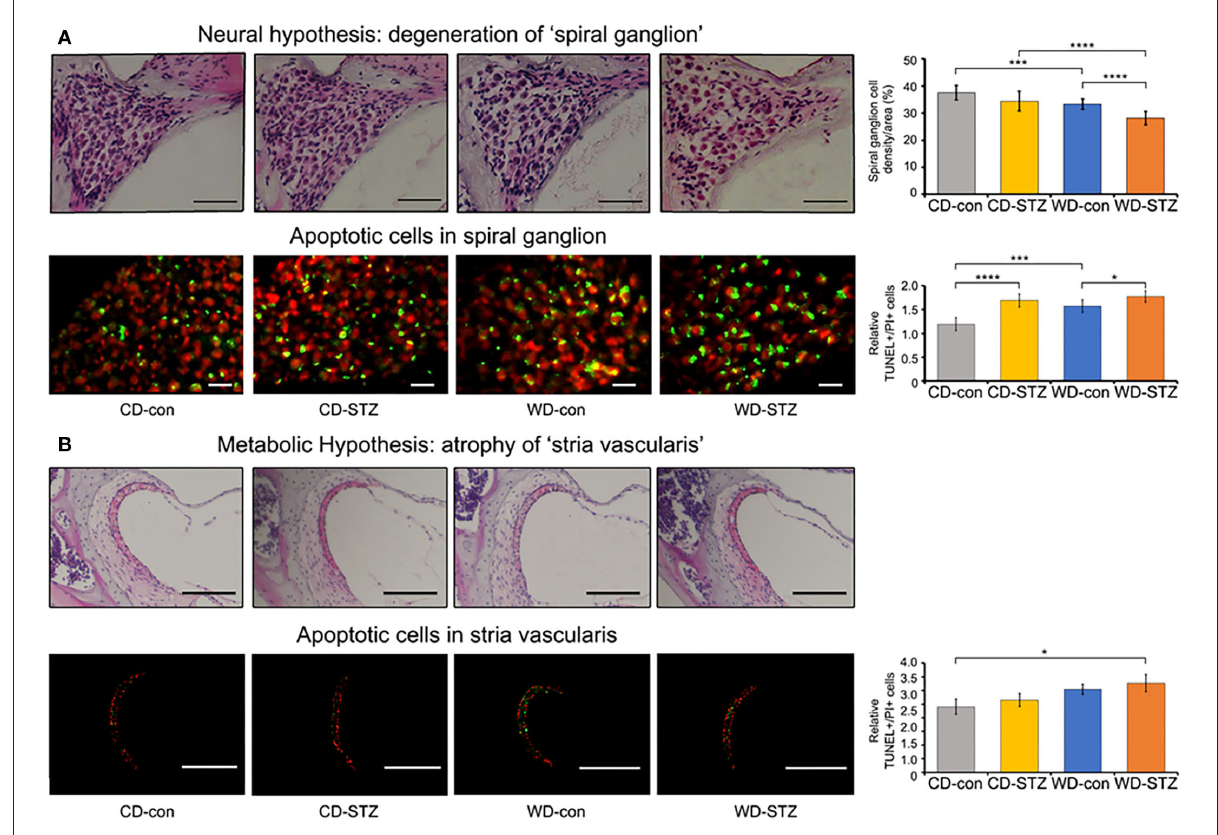
FIGURE7 Histological analysis of the cochlear spiral ganglion neurons (SGNs) and stria vascularis. Terminal deoxynucleotidyl transferase dUTP nick end labeling (TUNEL, green) and propidium iodide (PI, red) staining were used to detect apoptosis in the SGNs (A) and stria vascularis (B) at 24 weeks of age. The TUNEL + /PI + ratio of SGNs was significantly different between all groups (A) , while that of stria vascularis was significantly different between the CD-con and WD-STZ groups (B) . * p < 0.05, *** p < 0.001, and **** p < 0.0001. Scale bars correspond to 50 µ m.